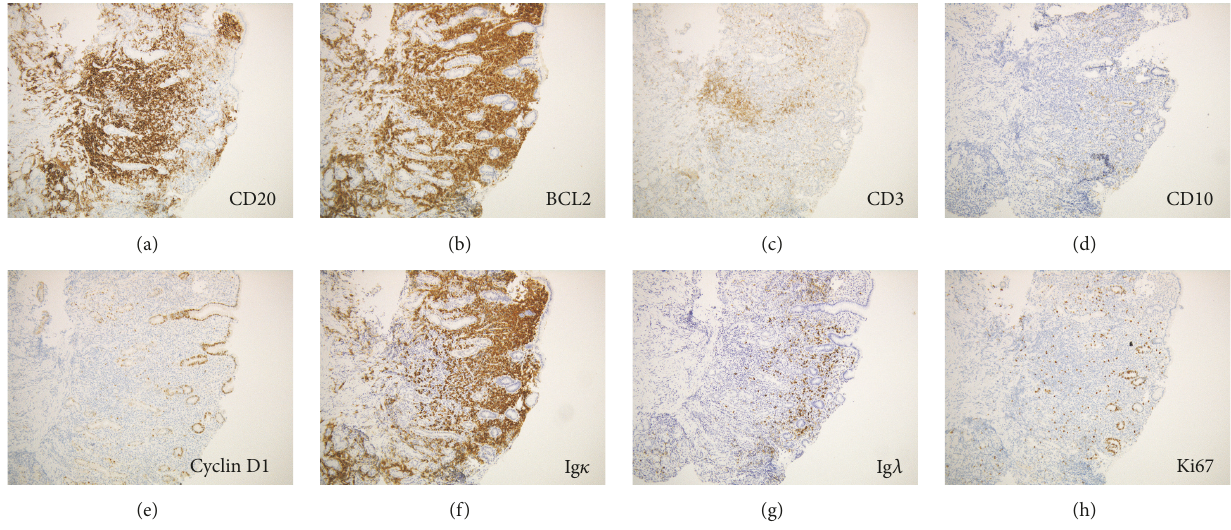
Figure 3: Pathological images with immunostaining. The infiltrating cells are positive for CD20 (a) and BCL2 (b), while they are negative for CD3 (c), CD10 (d), and cyclin D1 (e). In situ hybridization for immunoglobulin light chains shows positive results for immunoglobulin light chain 𝜅 (f) and negative results for light chain 𝜆 (g).